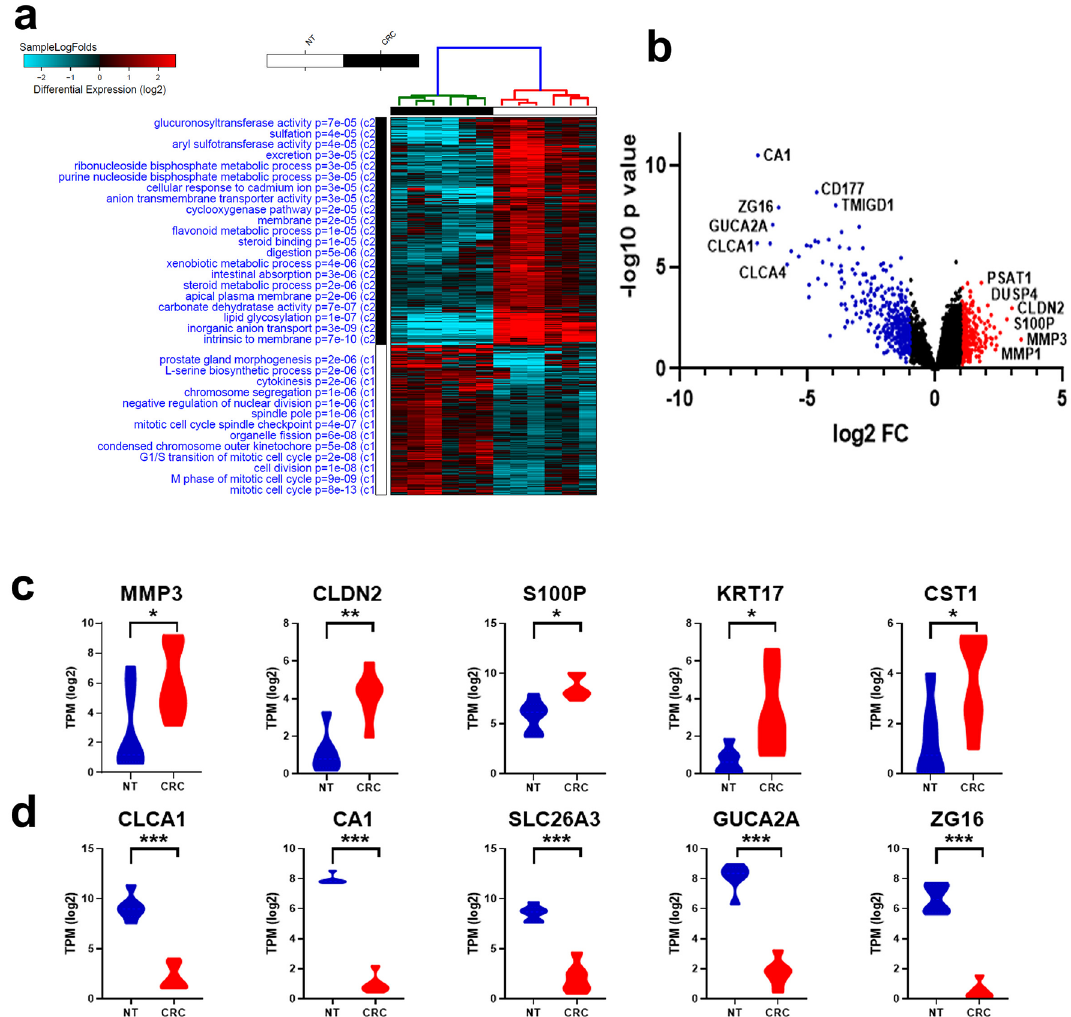
Figure 1. Alteration in mRNA expression in CRC compared to NT. (a) Hierarchical clustering of CRC (n = 6) and adjacent normal tissue (n = 6) based on differentially expressed mRNAs between the two groups. Each column represents one sample and each row represents an mRNA. Expression level of each mRNA (log2) in a single sample is depicted according to the color scale. (b) Volcano plot representation altered mRNAs in CRC vs. NT. Red and blue colors indicate the genes with significant increased or decreased expression (− 2.0 ≥ FC ≥ 2.0, p < 0.05), respectively, while black color indicates genes with no significant change. Expression of top five upregulated (c) or downregulated (d) mRNAs in CRC vs NT based on RNA-Seq